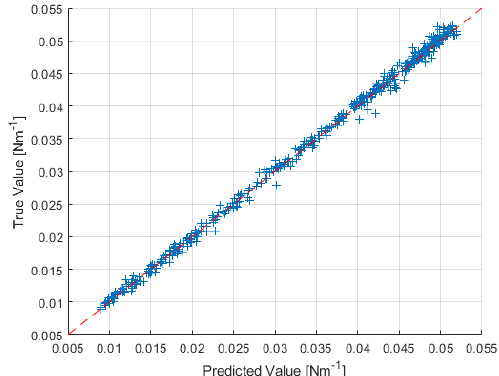
Figure 9. Root mean square error for training set (blue line) and validation set (black line). The true values Y versus the predicted ones for the validation set is plotted in Figure 10; the values plotted in Figure 11 are denormalized to the original range.